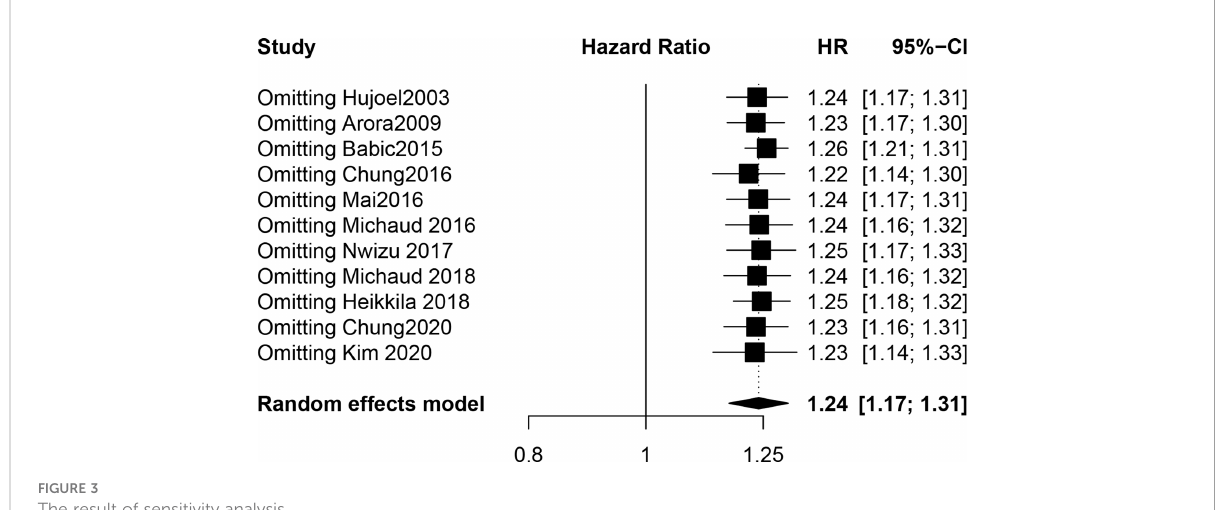
FIGURE 3 The result of sensitivity analysis.